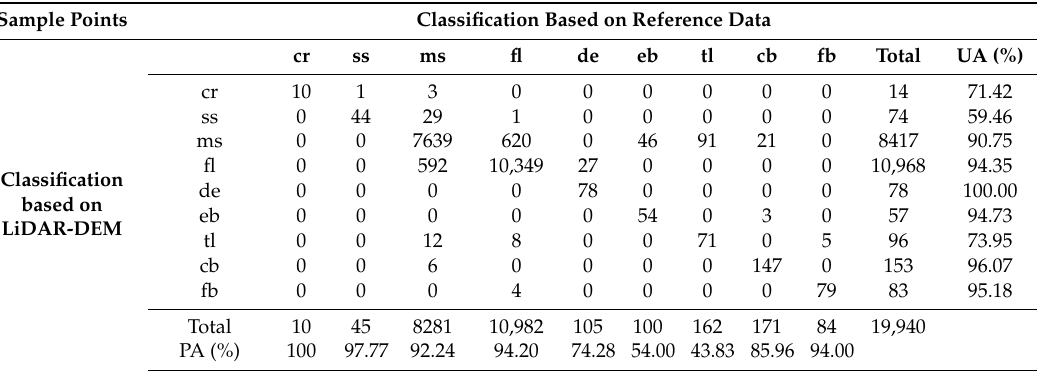
Table 5. Confusion matrix for landform classification based on the LiDAR-DEM and reference data (sample points) set for whole study area. Where cr is crest, ms is moderate hillside slope, ss is steep hillside slope, fl is flat land (unspecified), de is depression (open, closed), eb is embankment, tl is terraced land, cb is channel bank and fb is floodplain.